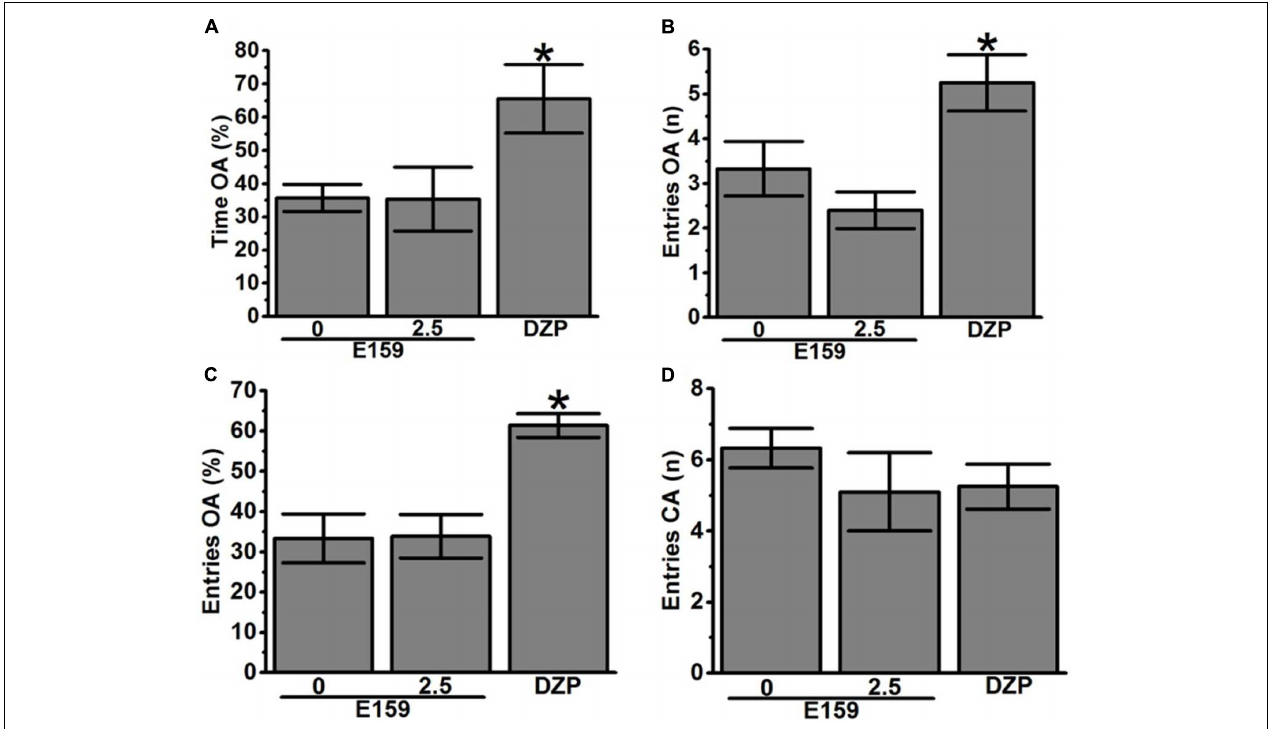
FIGURE 7 | Effects of acute E159 pretreatment on exploratory behavior in the EPM test. E159 (0 or 2.5 mg/kg) did not change the percentage of time spent on the open arms of the EPM (A) , the number of entries into the open arms (B) , and the percentage of entries into the open arms (C) . Pretreatment with the H3R antagonist/inverse agonist E159 did not affect the number of closed arm entries (D) . However, DZP significantly increased the percentage of time spent on the open arms of the EPM (A) , increased the number of entries into the open arms (B) and the percentage of entries into the open arms (C) , without significant alteration in the number of closed arm entries (D) . Data are expressed as mean ± SEM ( n = 8–10). ∗ P < 0.05 for the value of DZP-treated group vs. the value of the E159 (Saline)- or (2.5 mg)-treated